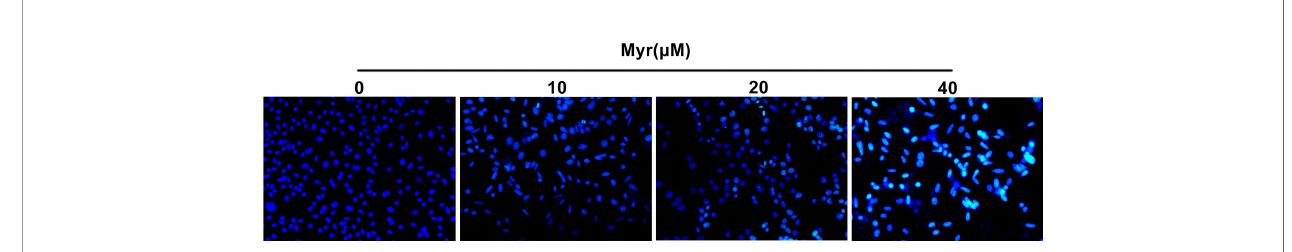
FIGURE 5 | Effects of different concentrations of Myr on SKOV3 apoptosis. After treating SKOV3 cells with Myr at 0, 10, 20 and 40 m M for 24 h, Hoechst 33258 was used to detect apoptosis. Representative fl uorescence images are shown at ×100 magni fi